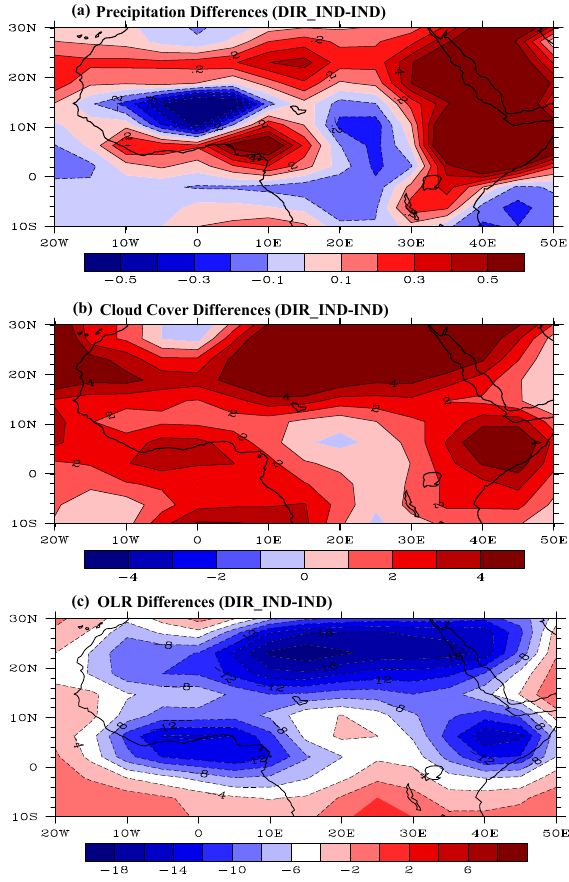
Fig. 7. JJA differences in (a) precipitation (mm day − 1 ) , (b) cloud cover (%), and (c) OLR (Wm − 2 ) between experiments DIR IND and